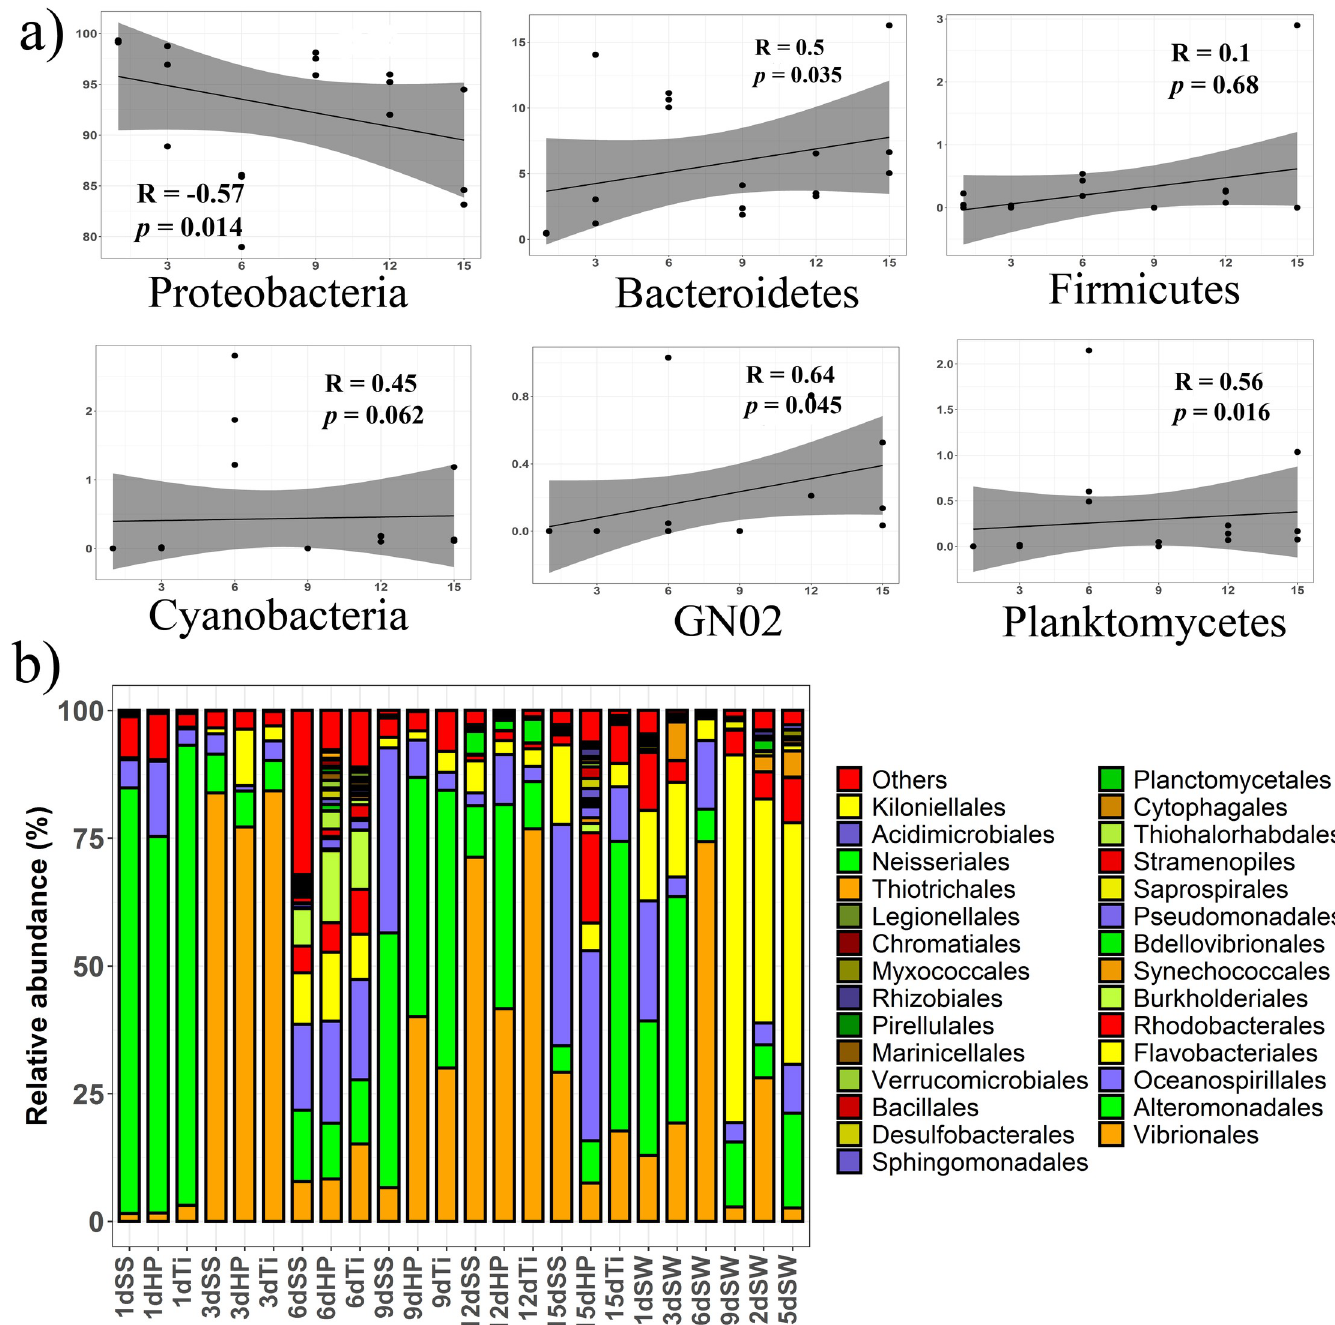
Fig 4. Temporal dynamics of the relative abundance of biofilm-forming bacterial communities. a) Spearman correlation plots of six dominant bacterial phyla over days. “R” represents the Spearman correlation coefficient. b) Stacked bar plots showing the relative abundance of dominant taxonomic groups at order level. Only those taxonomic groups that constitute for more than 0.5% of the total community are